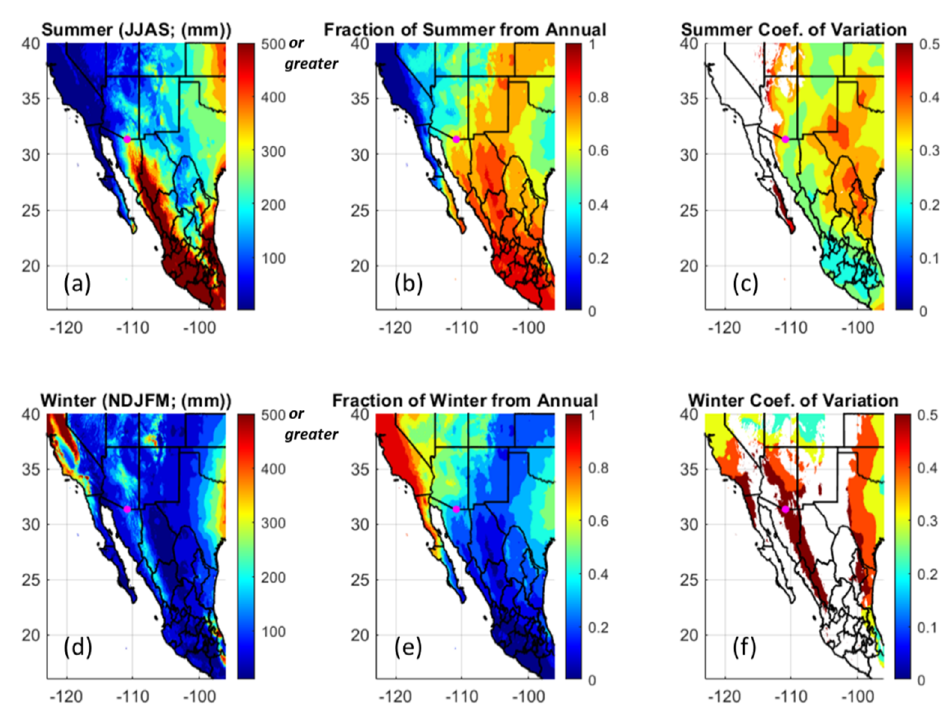
Figure 5. Average 1981–2020 summer and winter precipitation (( a ) and ( d ) for summer and winter, respectively), their portion from the average annual precipitation (( b ) and ( e ) for summer and winter, respectively), and their inter-annual variability represented by the coefficient of variation for locations with average seasonal rainfall that exceed 100 mm (( c ) and ( f ) for summer and winter, respectively). The purple dots demark the Santa Cruz River at its crossing of the international border from Sonora Mexico to Arizona U.S. The dataset is from the global monthly 4 km TerraClimate dataset [28].